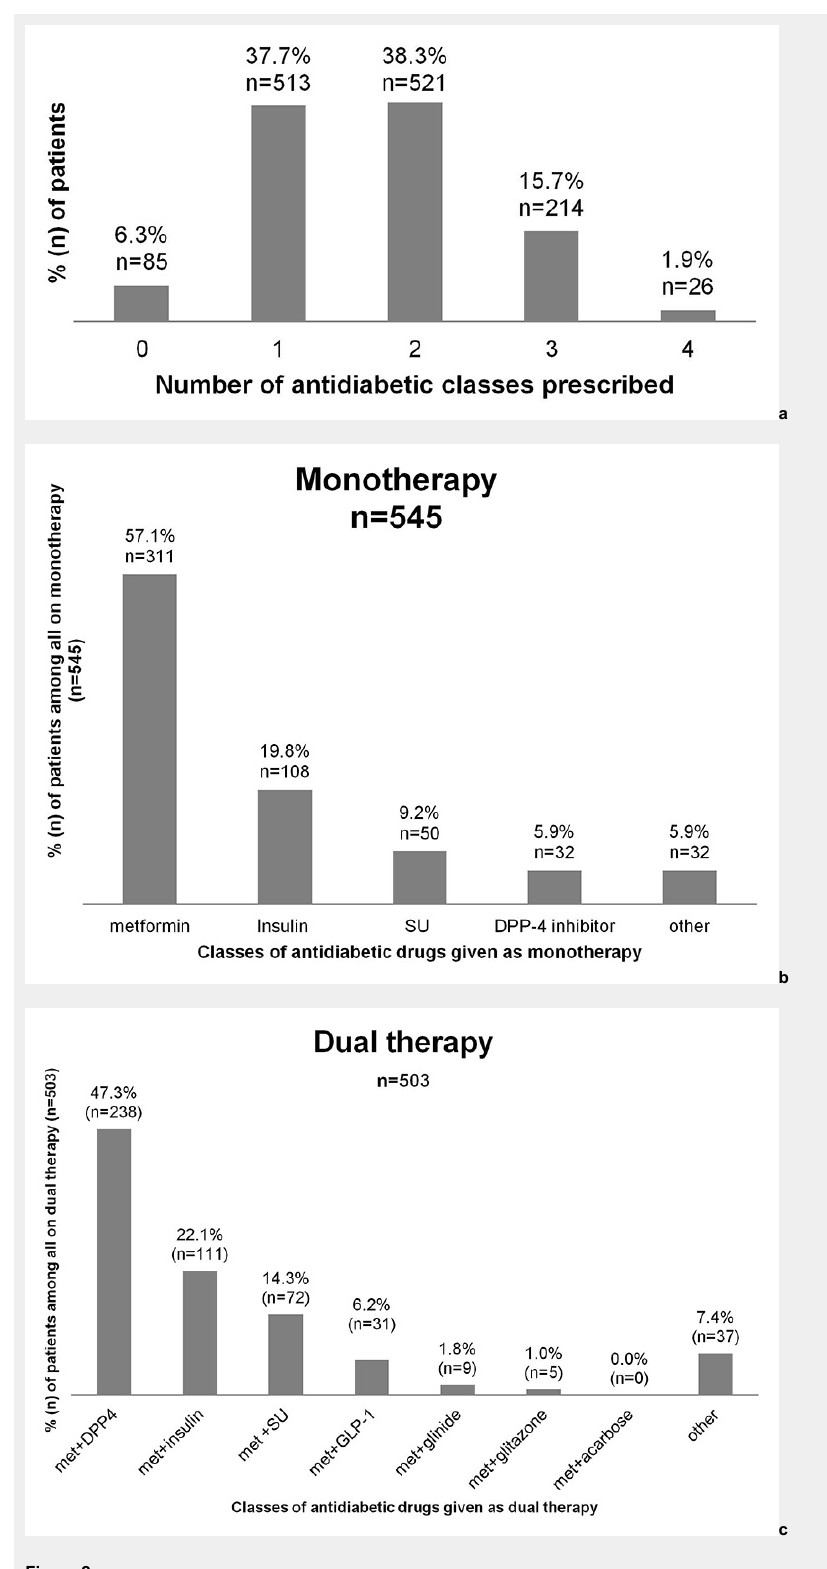
Figure 2 Antidiabetic therapy in diabetic patients treated in primary care practices. Number of classes prescribed (2a), classes of drugs prescribed as monotherapy (2b), classes of drugs prescribed as dual therapy (2c). DPP-4 = dipeptidyl-peptidase-4 inhibitor; GLP-1 = glucagon-like peptide-1 agonist; met = metformin; SU =